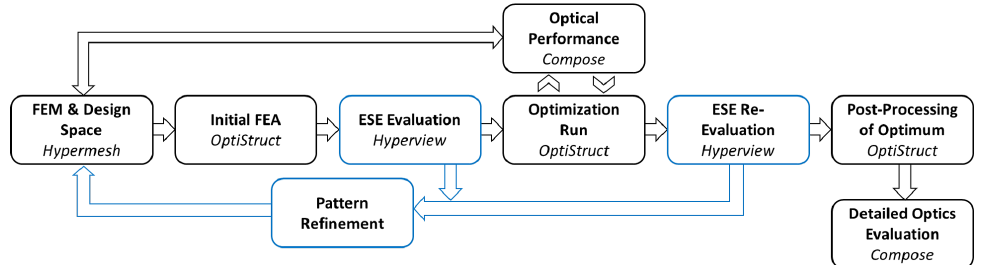
Figure 3. Optimization process where iterative pattern refinement is highlighted in